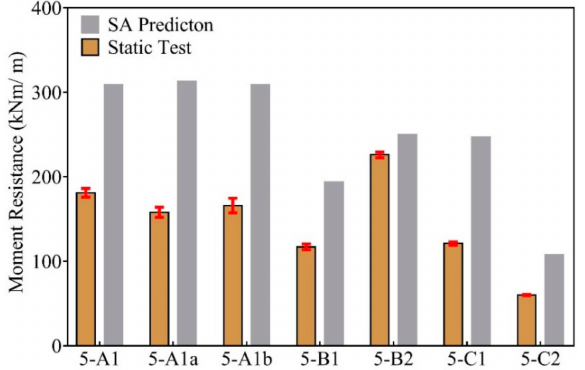
Figure 9. Average moment capacity of 5-layer MTPs by bending test and shear analogy